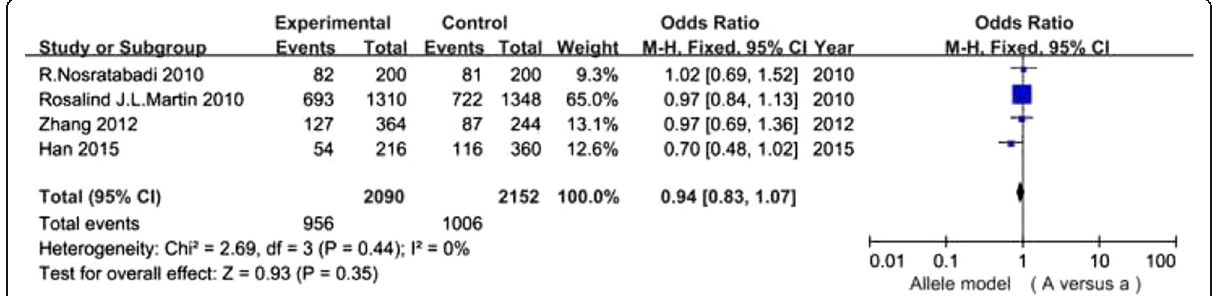
Fig. 5 Association of VDR ApaI gene polymorphism(A vs a) with DN susceptibility in overall